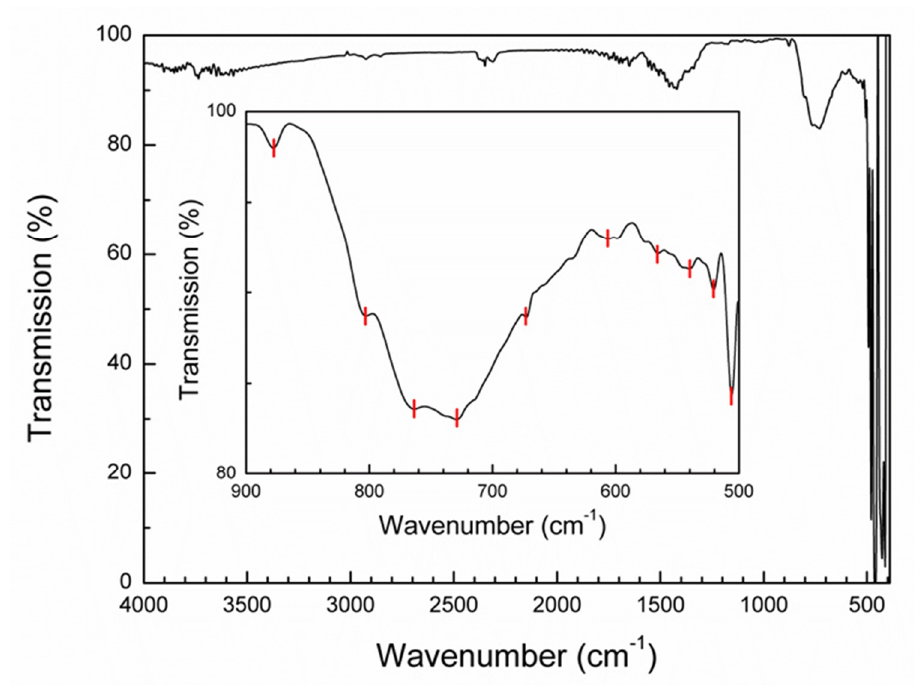
Figure 4. FTIR spectrum of LiZn(IO 3 ) 3 in the 4000–400 cm − 1 region. The inset shows a zoom in the 900–500 cm − 1 range. Ticks indicate position of the absorption peaks listed in the text.